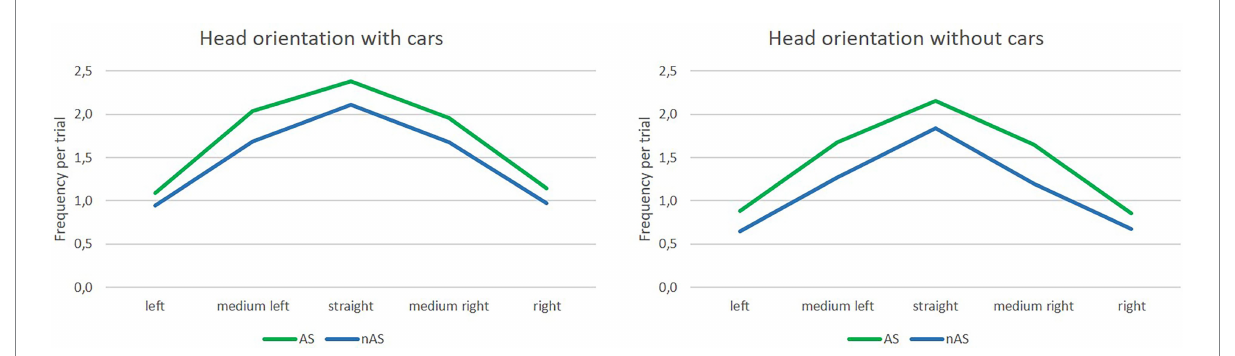
FIGURE 6 Means of frequencies of different orientations of head rotation in the VR experiment with and without cars, with (AS) and without (nAS) assistance